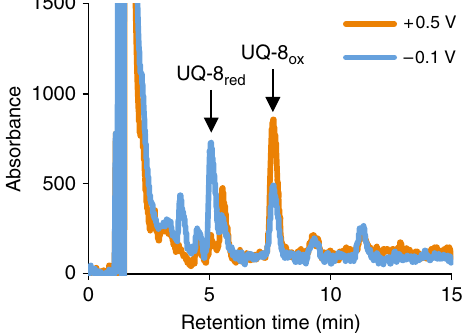
Fig. 5 Detection of UQ-8 in MR-1 cells exposed to different electrode potentials. The retention times of oxidized and reduced ubiquinones (UQ- 8 ox and UQ-8 red , respectively) are indicated by